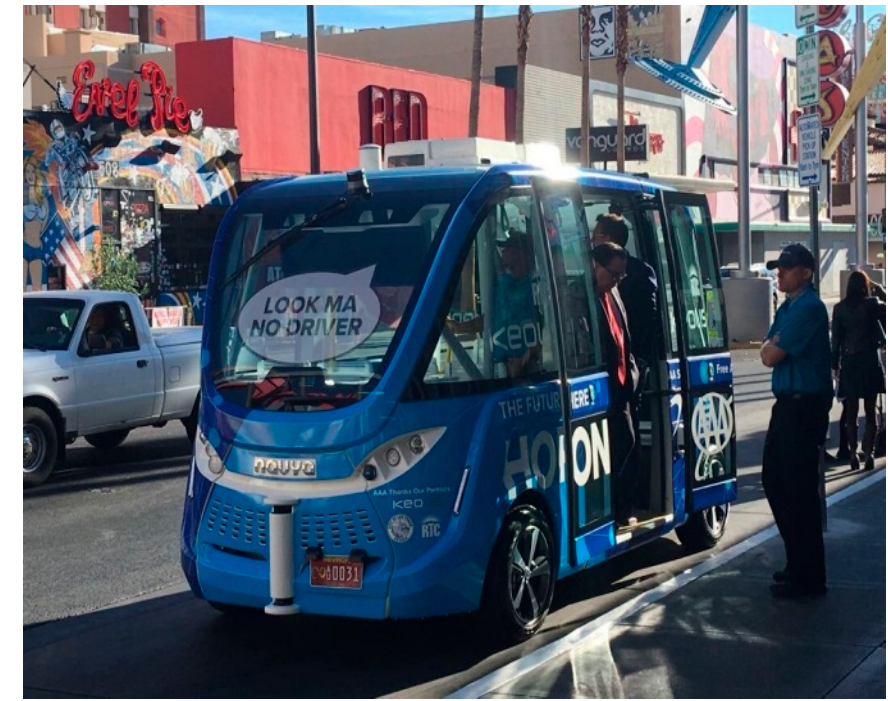
Figure 4. Example of an autonomous minibus.